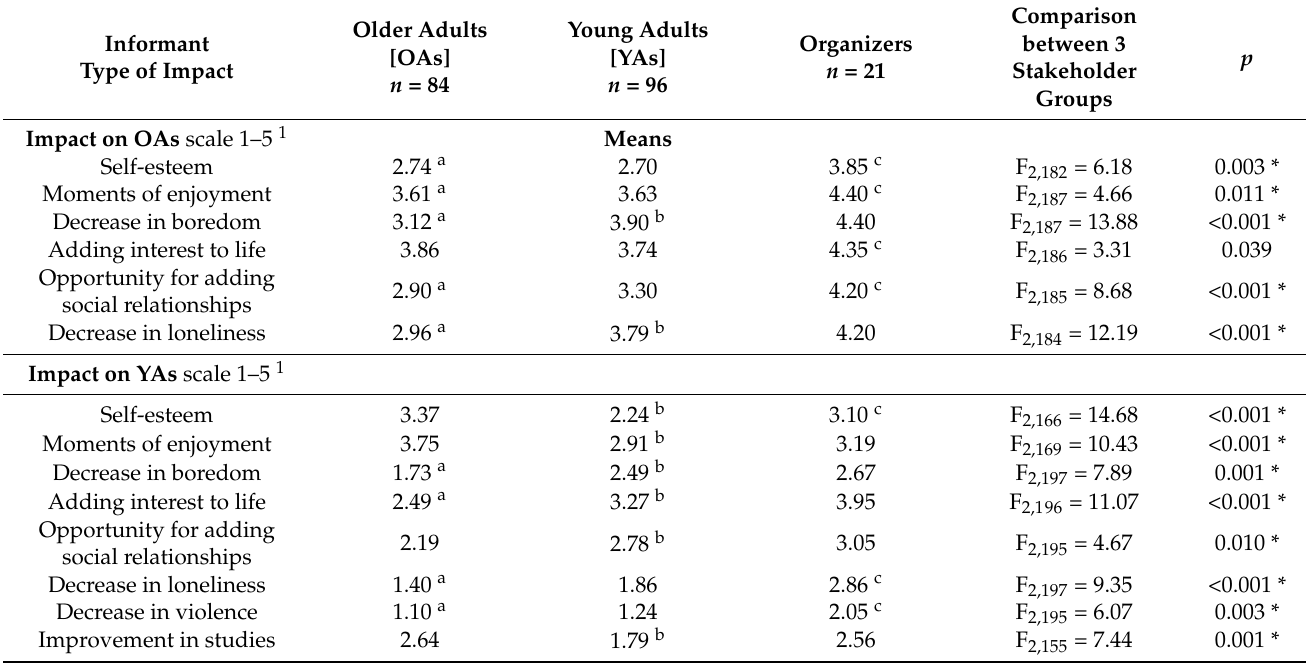
Table 2. Comparison of outcomes across